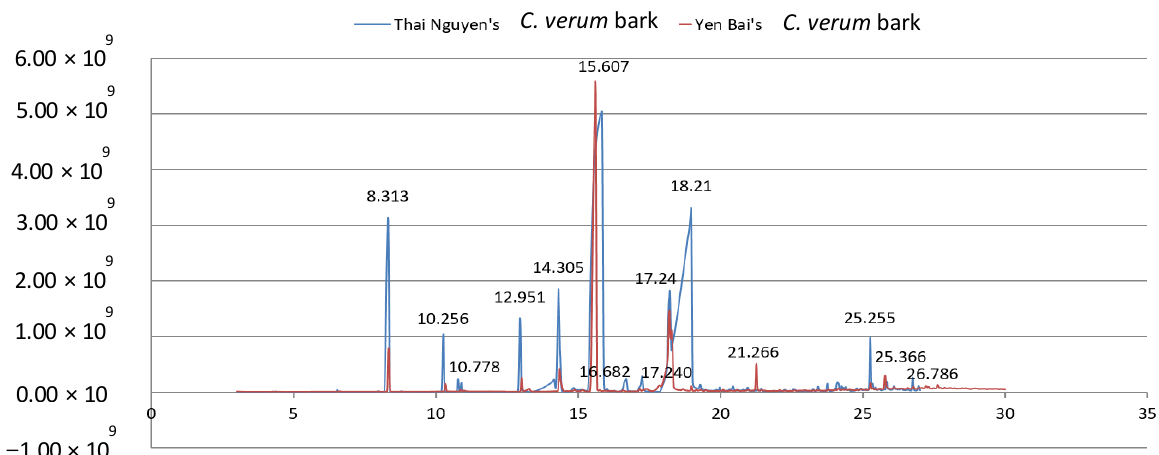
Figure 1. GC-FID spectra of EOs extracted from C. verum leaves cultivated in Thai Nguyen and Yen Bai, with n-hexane used as the extraction solvent.